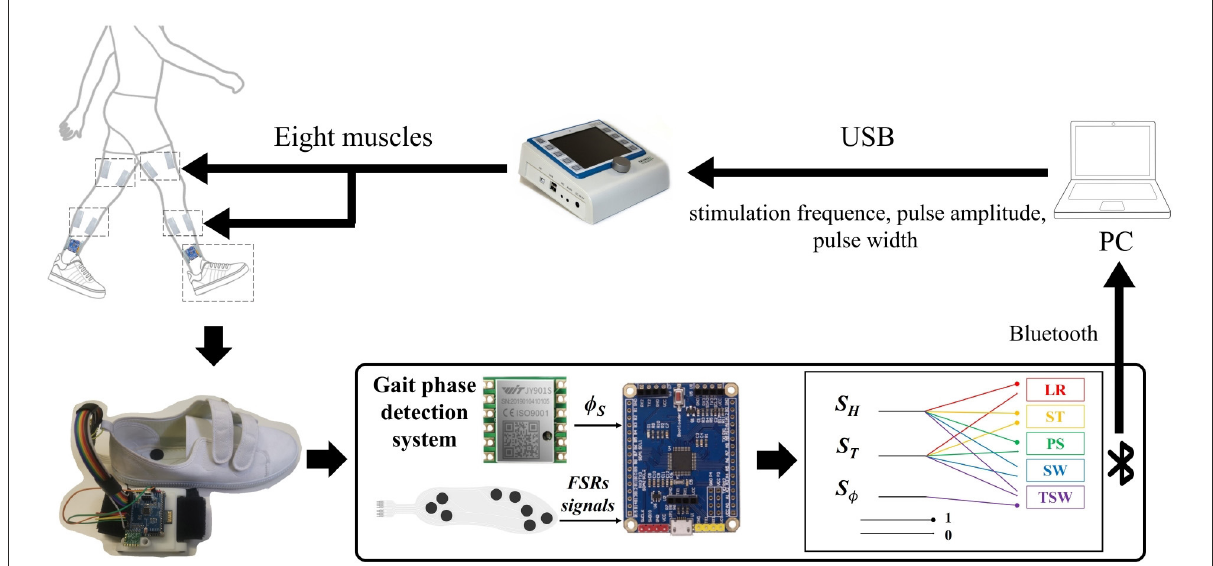
FIGURE1 The structure of the functional electrical stimulation (FES) walking assistance system. The system consists of three main parts: a programmable electrical stimulator, a real-time gait phase detection device, and a host computer. The FSR-embedded insole and an inertial measurement unit (IMU) chip were connected to an STM32 microcontroller that detected gait phases by an IF-THEN type finite state machine during walking. The sensory signals, including gait phase detection result and shank angle, were transmitted to the host PC via Bluetooth. At the same time, the adaptive FES controller generated electrical stimulation sequences for the muscles. The stimulation parameters were adapted and applied to eight muscles by the programmable electrical stimulator RehaStim through a USB 3.1 port.